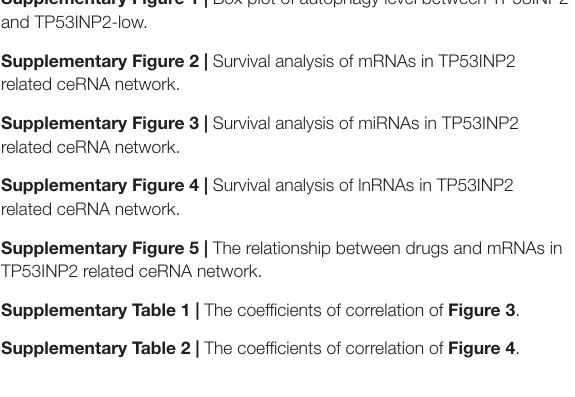
Supplementary Figure 1 | Box plot of autophagy level between TP53INP2-high and TP53INP2-low. Supplementary Figure 2 | Survival analysis of mRNAs in TP53INP2 related ceRNA network. Supplementary Figure 3 | Survival analysis of miRNAs in TP53INP2 related ceRNA network. Supplementary Figure 4 | Survival analysis of lnRNAs in TP53INP2 related ceRNA network. Supplementary Figure 5 | The relationship between drugs and mRNAs in TP53INP2 related ceRNA network. Supplementary Table 1 | The coefficients of correlation of Figure 3 . Supplementary Table 2 | The coefficients of correlation of Figure 4